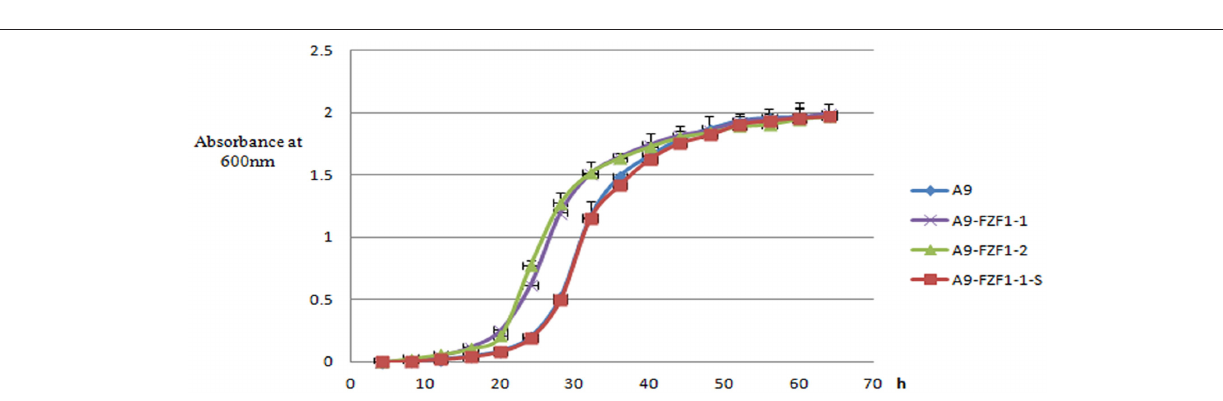
FIGURE 3 | The growth curve of different strains. The data are plotted as the means and standard deviations of the triplicate values. The culture medium was fresh liquid YPD, and the data were collected every 4h, with growth measured using light absorption at